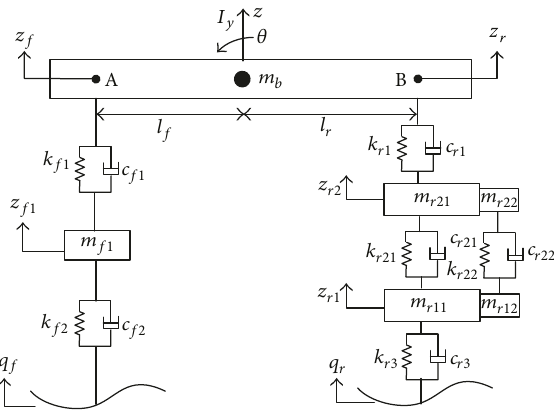
Figure 2: IWM-driven EV 1/2 physical